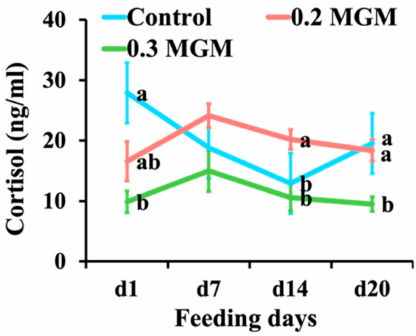
Figure 5. Effects of MGM-P supplementation on the blood cortisol concentration of weaned piglets. Blood was collected on d1 before the provision of feed with MGM-P on the day of weaning. Values are expressed as mean ± SEM; n = 8. Different lowercase letters on the right side of the nodes indicate significant differences ( p < 0.05; Tukey HSD test).